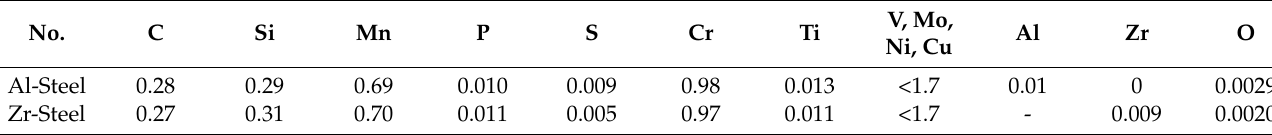
Table 1. Chemical composition of experimental steels